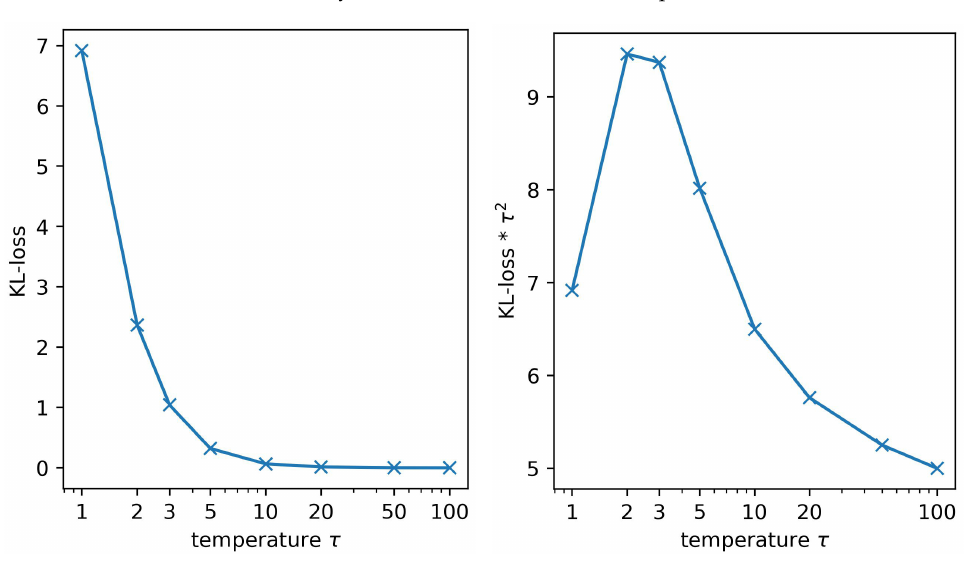
Figure 2. Comparison of the soft model output of LSR-OS at different temperatures τ . C8 is the predicted class. ( a ) Soft model distribution comparison; ( b ) corresponding KL-loss between different temperature outputs and the uniform distribution; ( c ) KL-loss multiplied by a factor τ 2